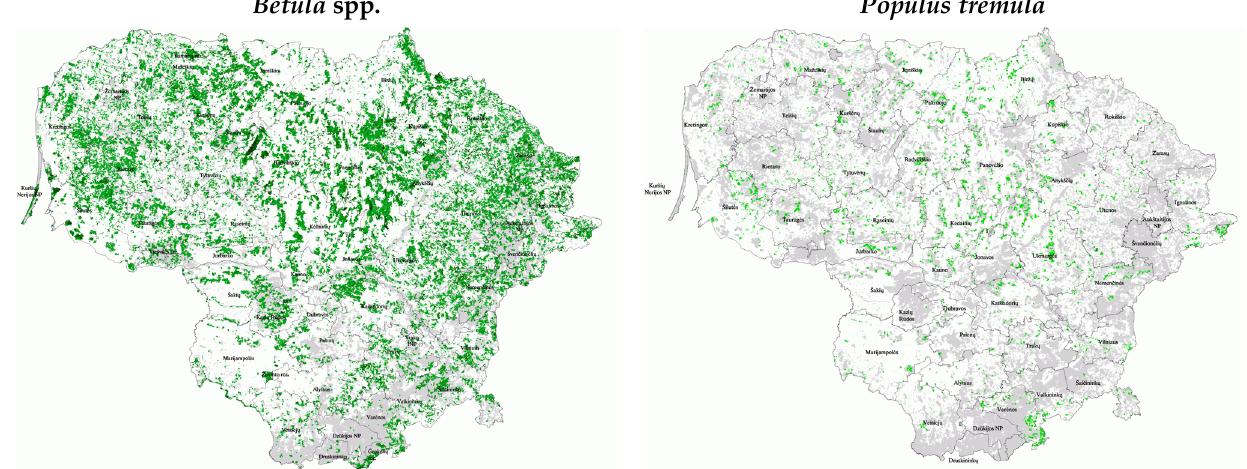
Figure 1. Distribution maps of Betula spp. and Populus tremula tree species in Lithuania. Distribution area of Betula and Populus tremula forests is shown in green color; distribution of other tree species is shown in gray color.